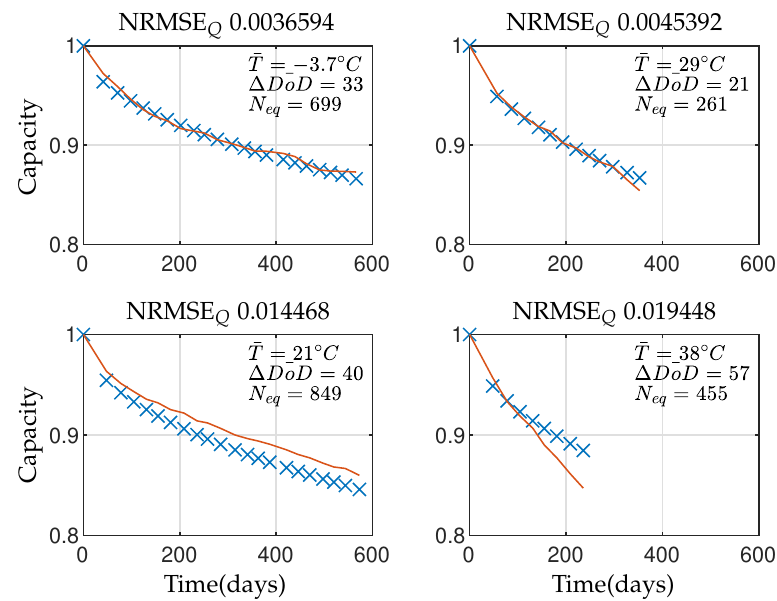
Figure 6. Model prediction(solid) for cells under different average temperatures, delta DoD and Figure 6. Predictions (solid) for cells under different average temperatures, delta DoD and numbers number of equivalent cycles with varying levels of accuracy. of equivalent cycles, with varying levels of accuracy.